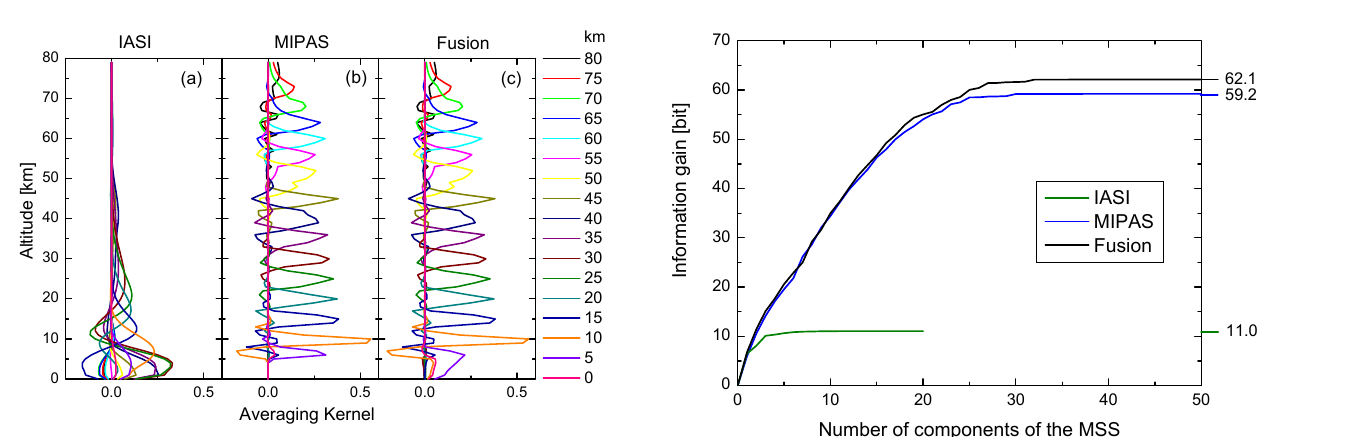
Fig. 6. Information gain as a function of the number of components used to represent the MSS in the simulated case for the profiles retrieved using only the IASI measurement (green line), only the MIPAS measurement (blue line) and the IASI-MIPAS data fusion (black line).